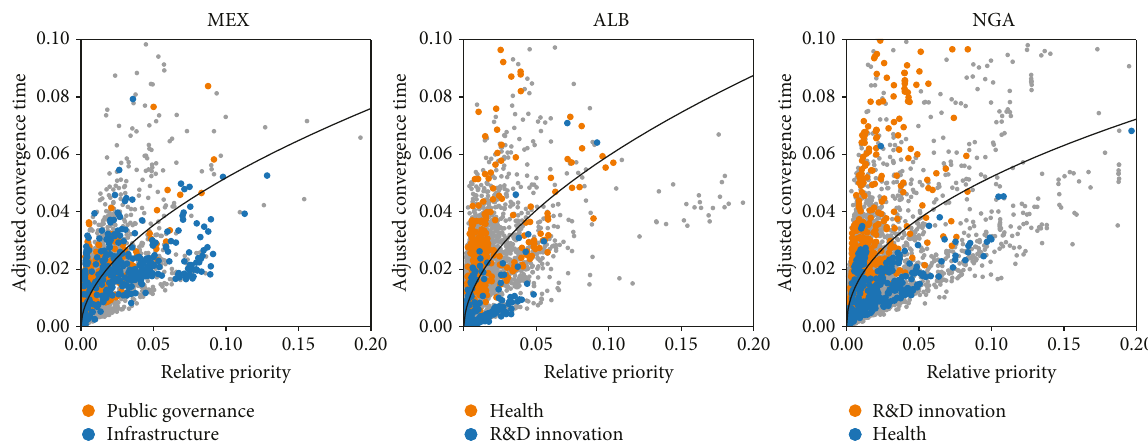
Figure 8: The most (blue) and the least (orange) resilient development pillars for three countries.